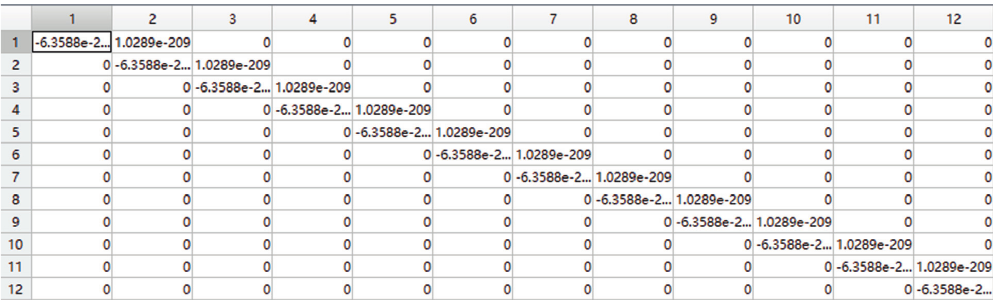
Figure 3: The result of Lemma 7.